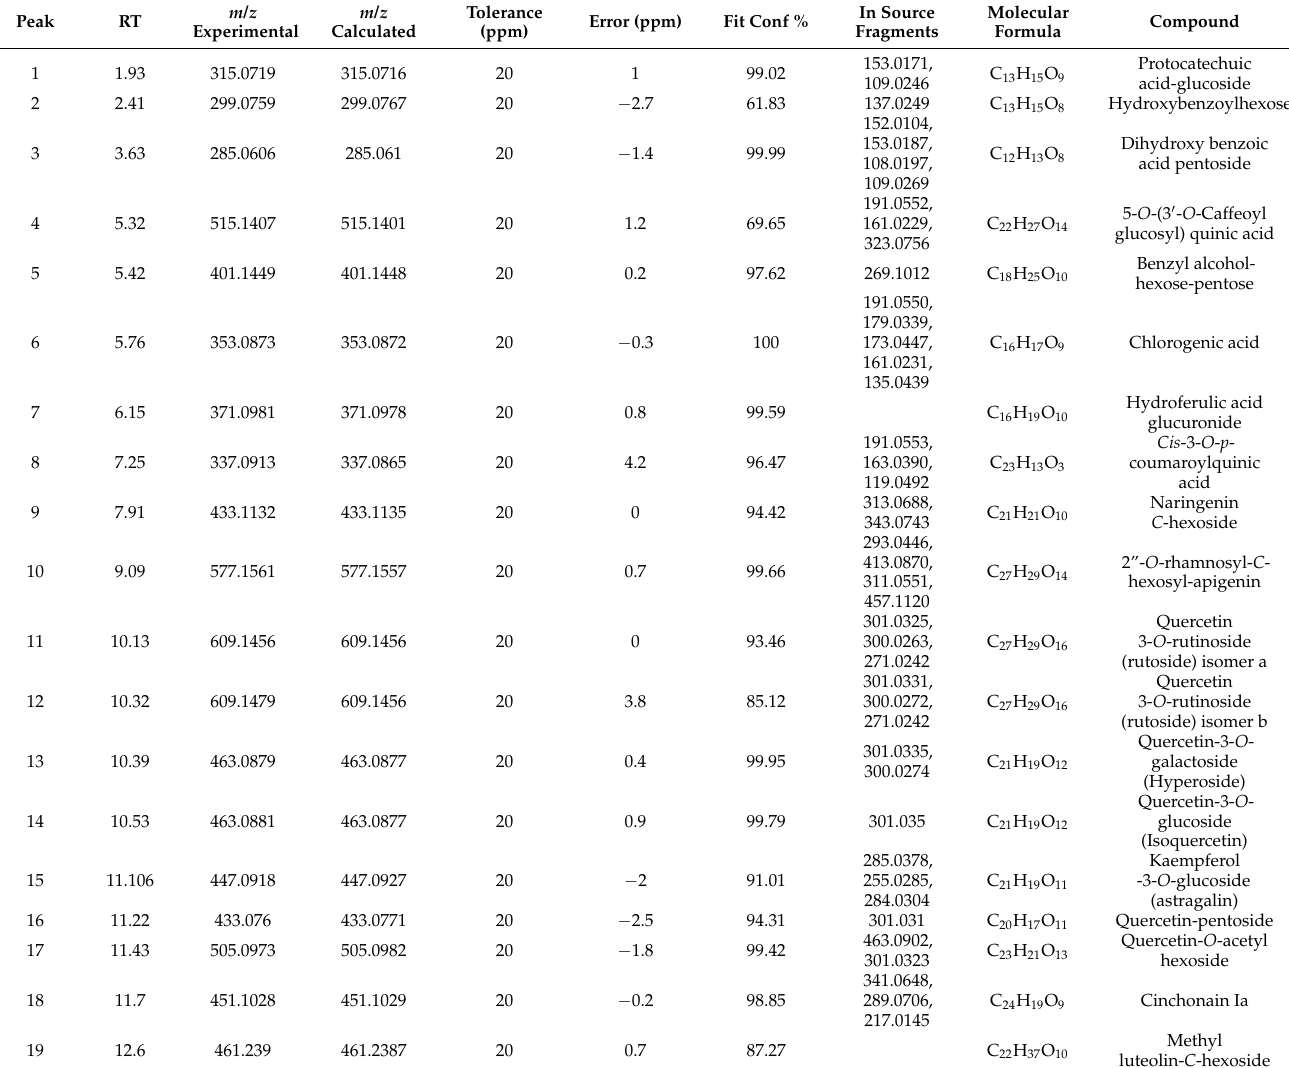
Table 4. Table of identification of phenolic compounds from optimum C. monogyna leaf extract by HPLC-MS.